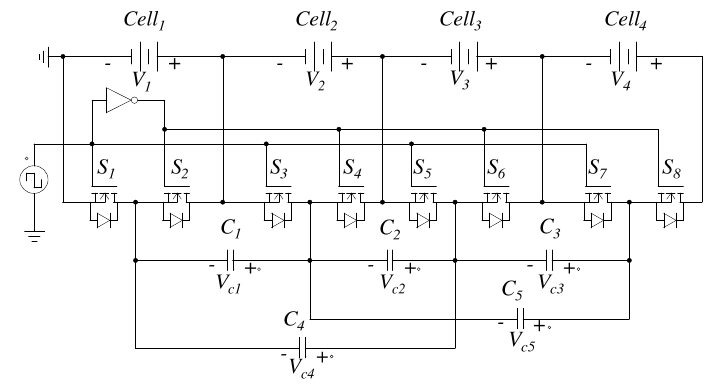
Figure 15. Double-tiered capacitor topology